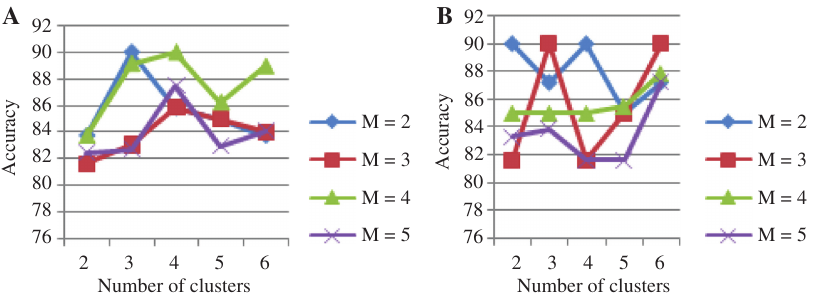
Figure 2: Accuracy Analysis Using (A) Dataset 1 and (B) Dataset